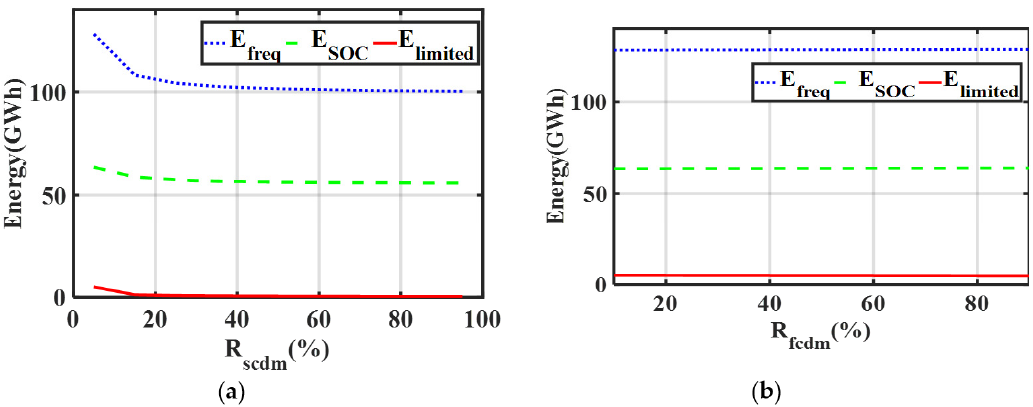
Figure 14. Objective function changes according to power output rate changes ( a ) Changes in R scdm ( b ) Changes in R fcdm